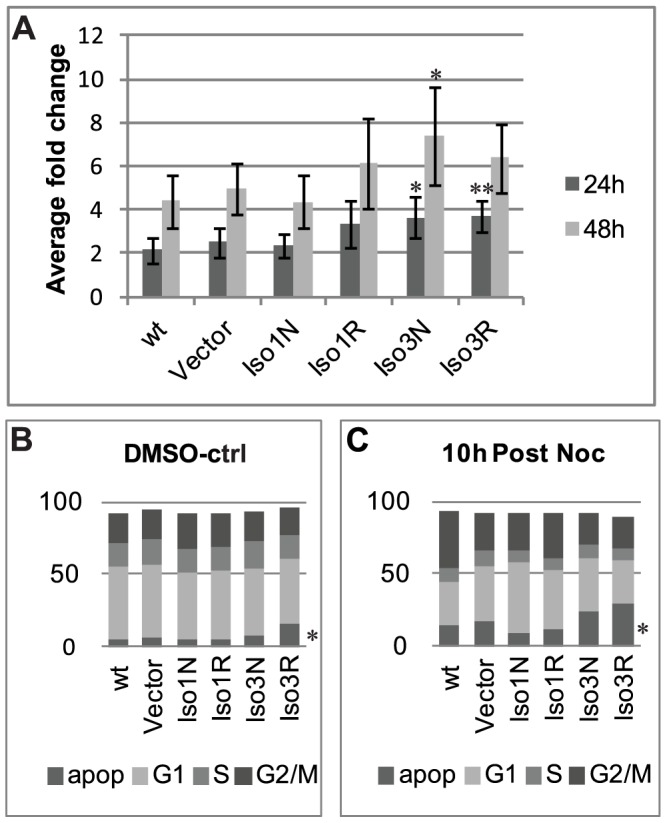
CCHCR1 isoform 3 overexpressing cells Iso3Non-risk and Iso3Risk multiply faster than other stable cell lines.(A) Cell proliferation was determined by counting the cell numbers with an automated cell counter (Scepter) during growth periods of 24 or 48 h. Iso1Non-risk (Iso1N) cells show similar proliferation as wild type (wt, HEK293) and vector-control (Vector) cells. The greatest difference is seen between the Iso1Non-risk and isoform 3-expressing cell lines (Iso3N, Iso3R) (P<0.003) after 24 h, the latter proliferating significantly faster. (B) Cell cycle is similar in all CCHCR1 cell lines shown by percentage values. Higher sub-apoptotic population (apop) in Iso3Risk (Iso3R) cells, however, indicates failure in cell cycle. Cell cycle progression was determined by treating the cells with 0.3 µM nocodazole (Noc) or DMSO-control over night, after which the medium was changed and the cells harvested and fixed at different time points (0 and 10 h shown). DNA was stained with propidium iodine for FACS analysis and the proportion of cells in each of the cell cycle stages (G1, S, G2/M) identified by using the relative DNA content. Asterisks show significant P-values calculated with values from the vector-control cell line and the representative cell line (*<0.05>**<0.01).